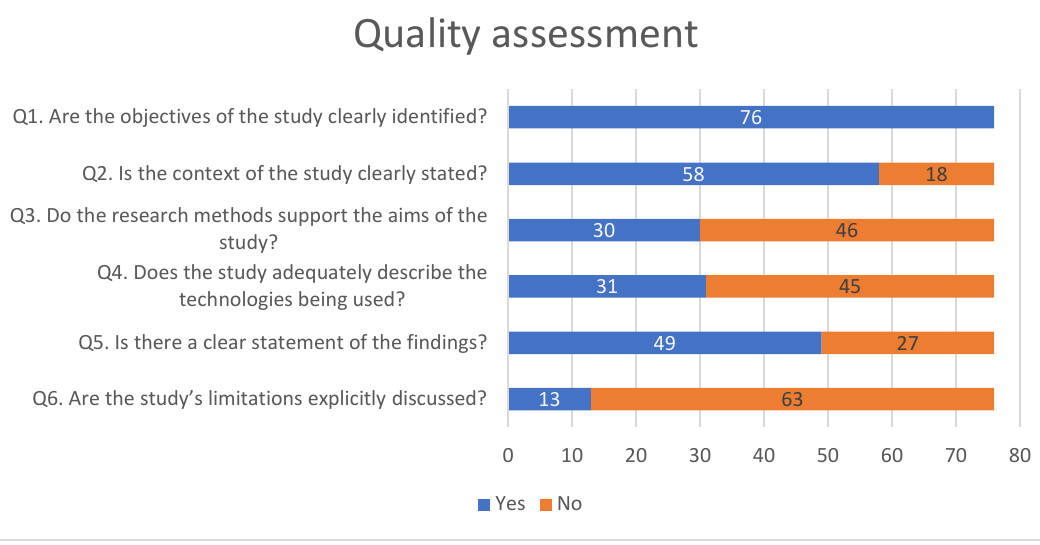
Figure 4. Methodological quality assessment of the included studies.